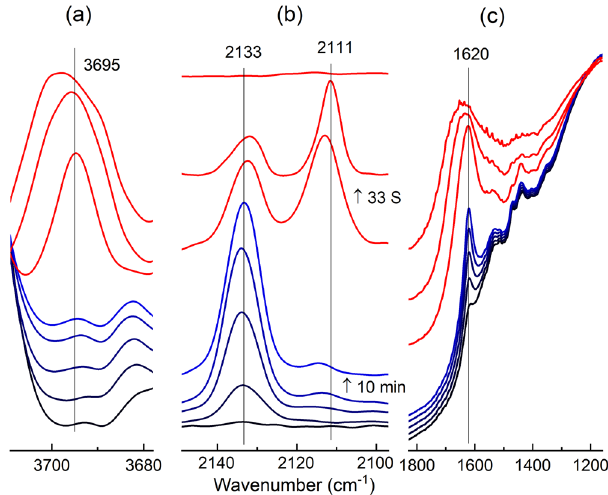
Fig. 4 DRIFTS spectra upon introduction of water vapor. Changes in the a hydroxyl, b carbonyl, and c water regions in the DRIFTS spectra of Cu/TiO 2 before (blue, collected every 10 min) and after (red, collected every 33 s) the introduction of water vapor into the IR